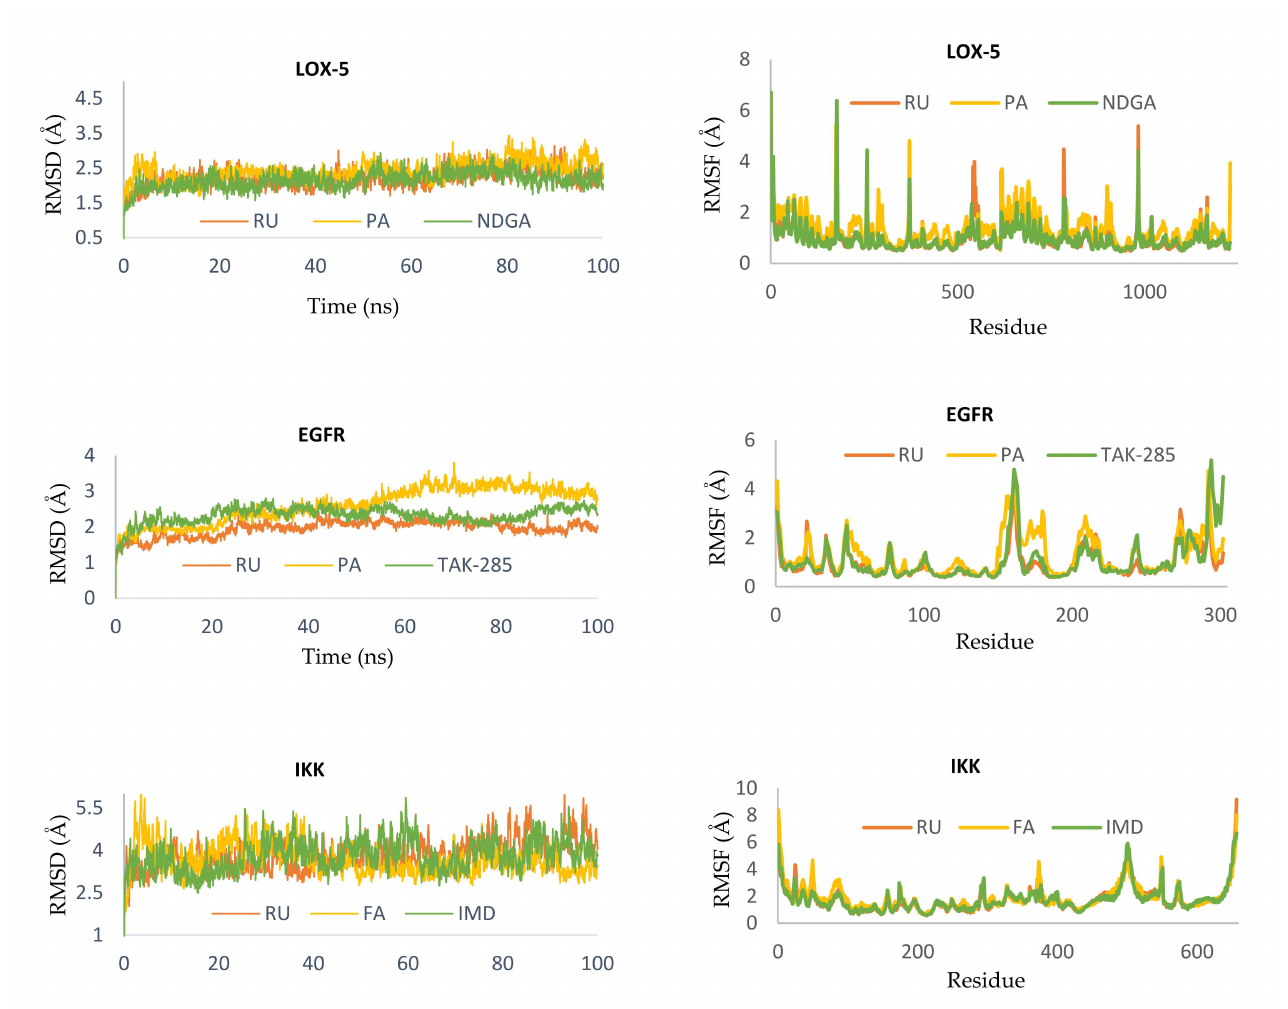
Figure 6. Superimposed RMSD graph of backbone and RMSF graph of residues for each target complexed with selected compounds and